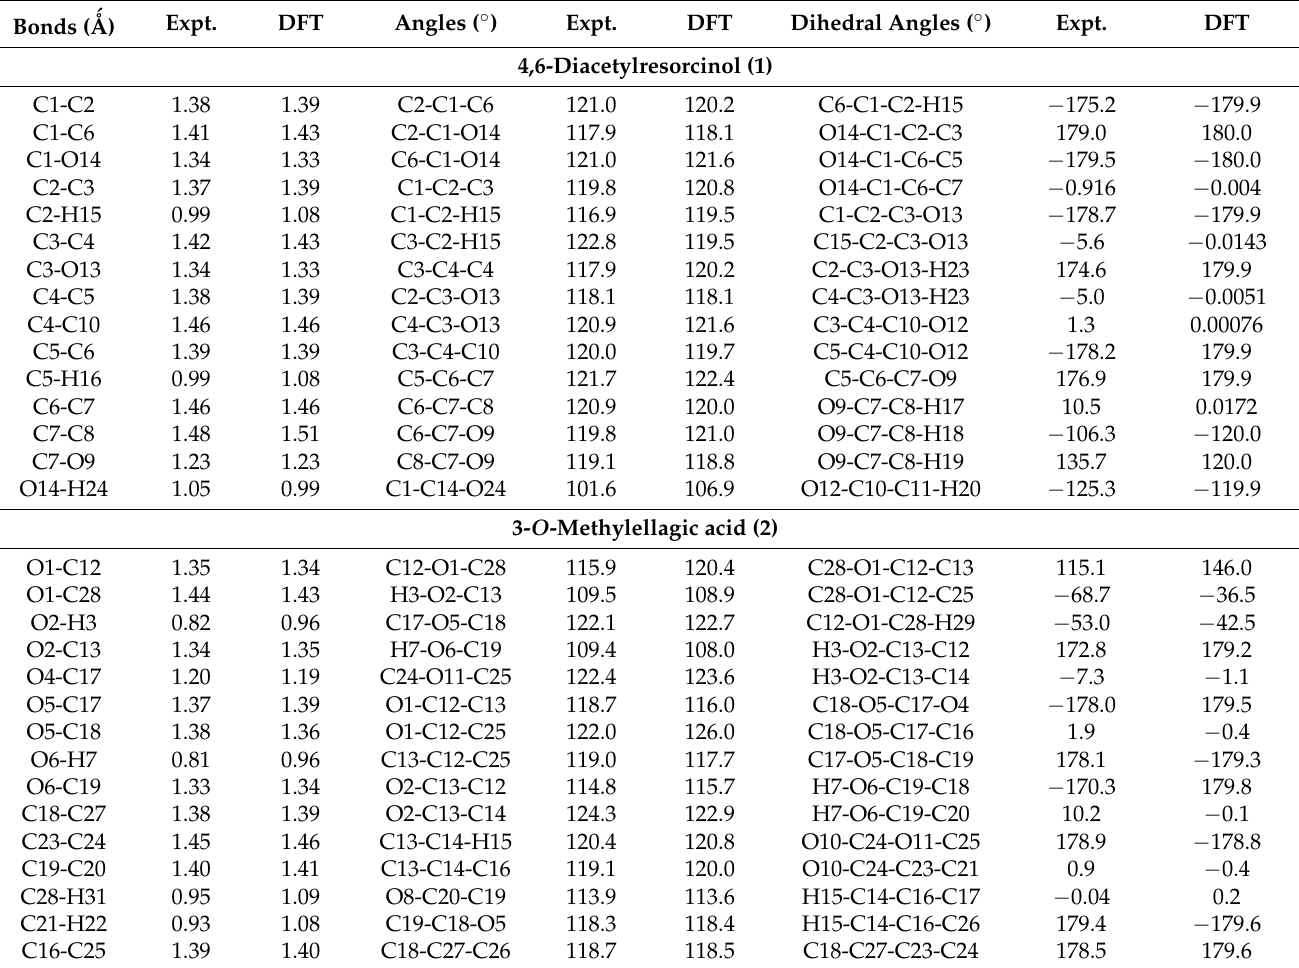
Table 1. Comparison of important bond lengths [Å] bond angles [ ◦ ] and dihedral angles [ ◦ ] obtained by X-ray study and DFT/B3LYP/6-311G(d,p) for molecules 1 and 2